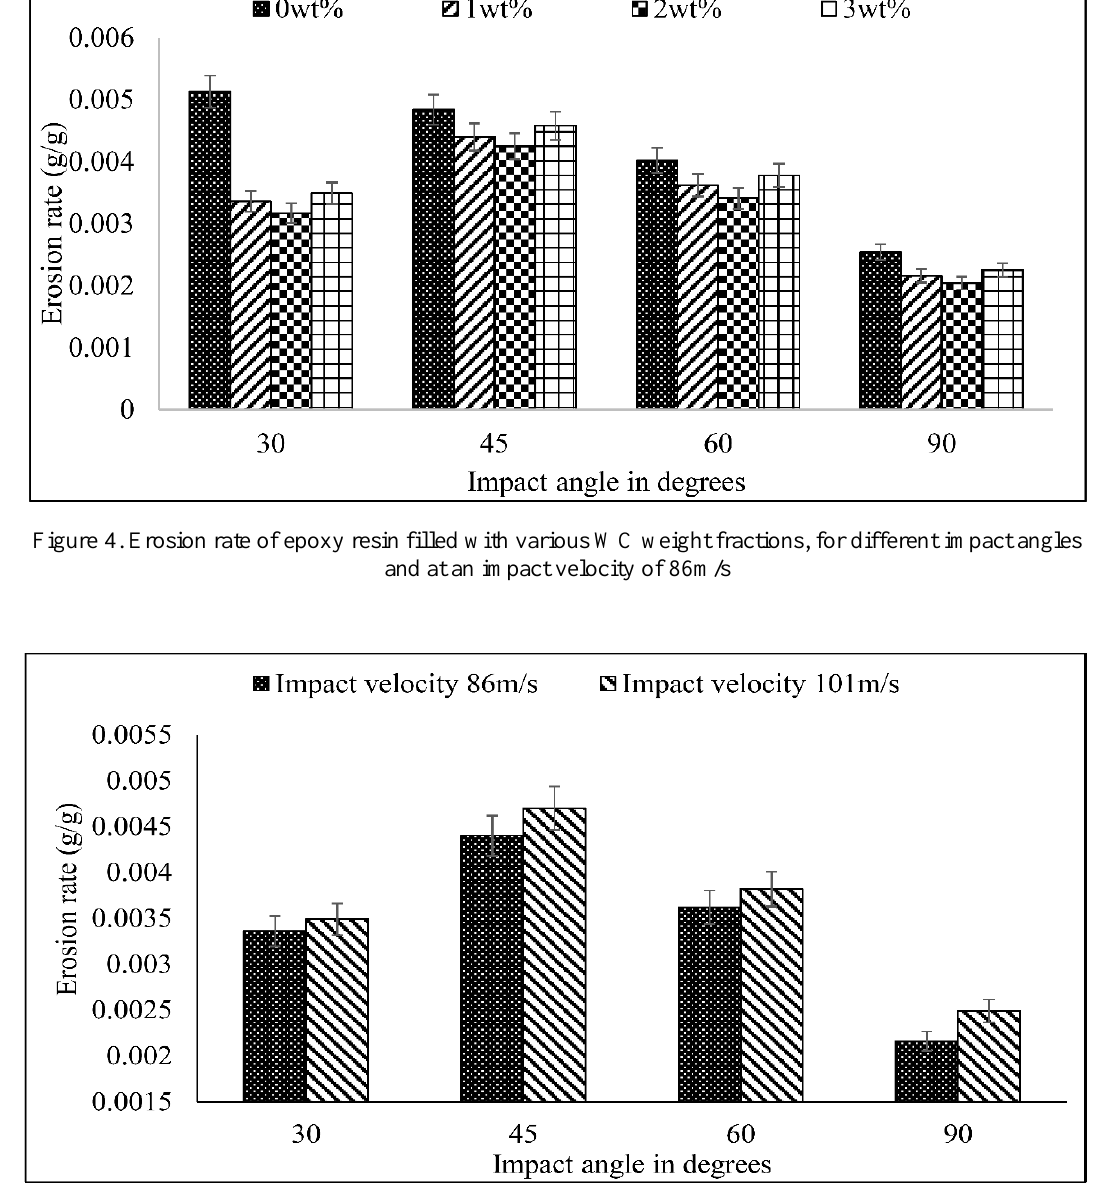
Figure 5. Erosion rate for 1wt% of filler nanocomposites at an impact velocity of 86m/s and